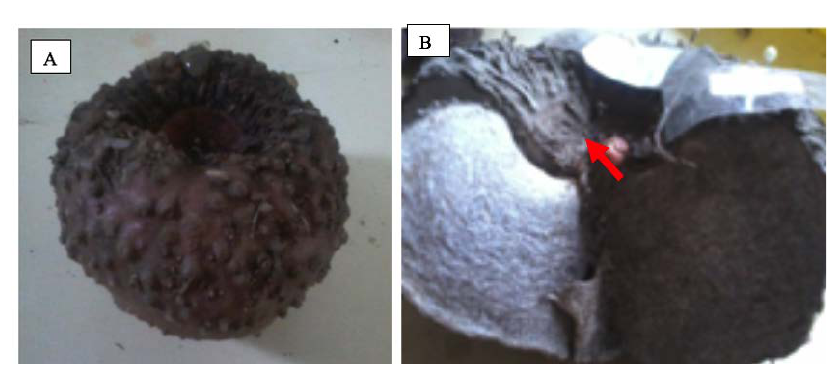
Figure 4. Tuber of A . muelleri at storage week zero (A), tuber of A. muelleri at storage week 10, beginning to show signs of